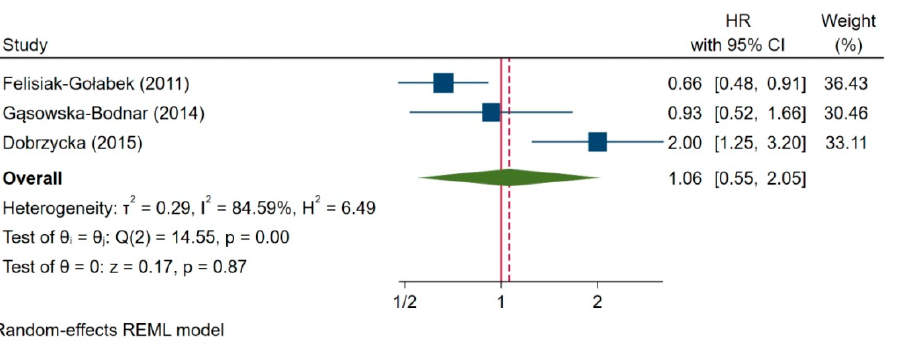
Figure 9. Impact of survivin expression on disease-free survival [25,27,29].